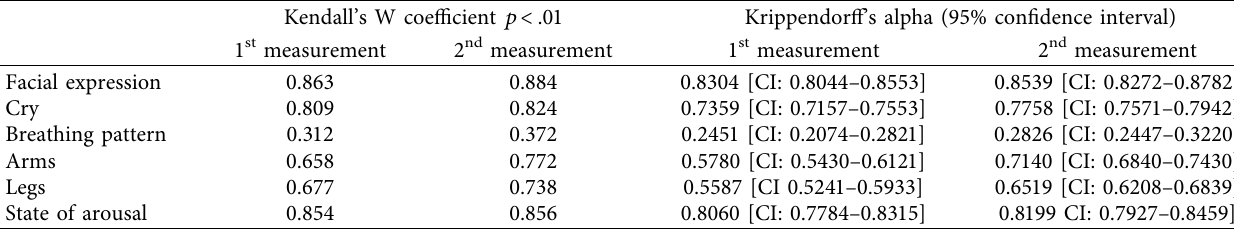
Table 7: NIPS, interrater agreement item analysis ( N � 34 in all